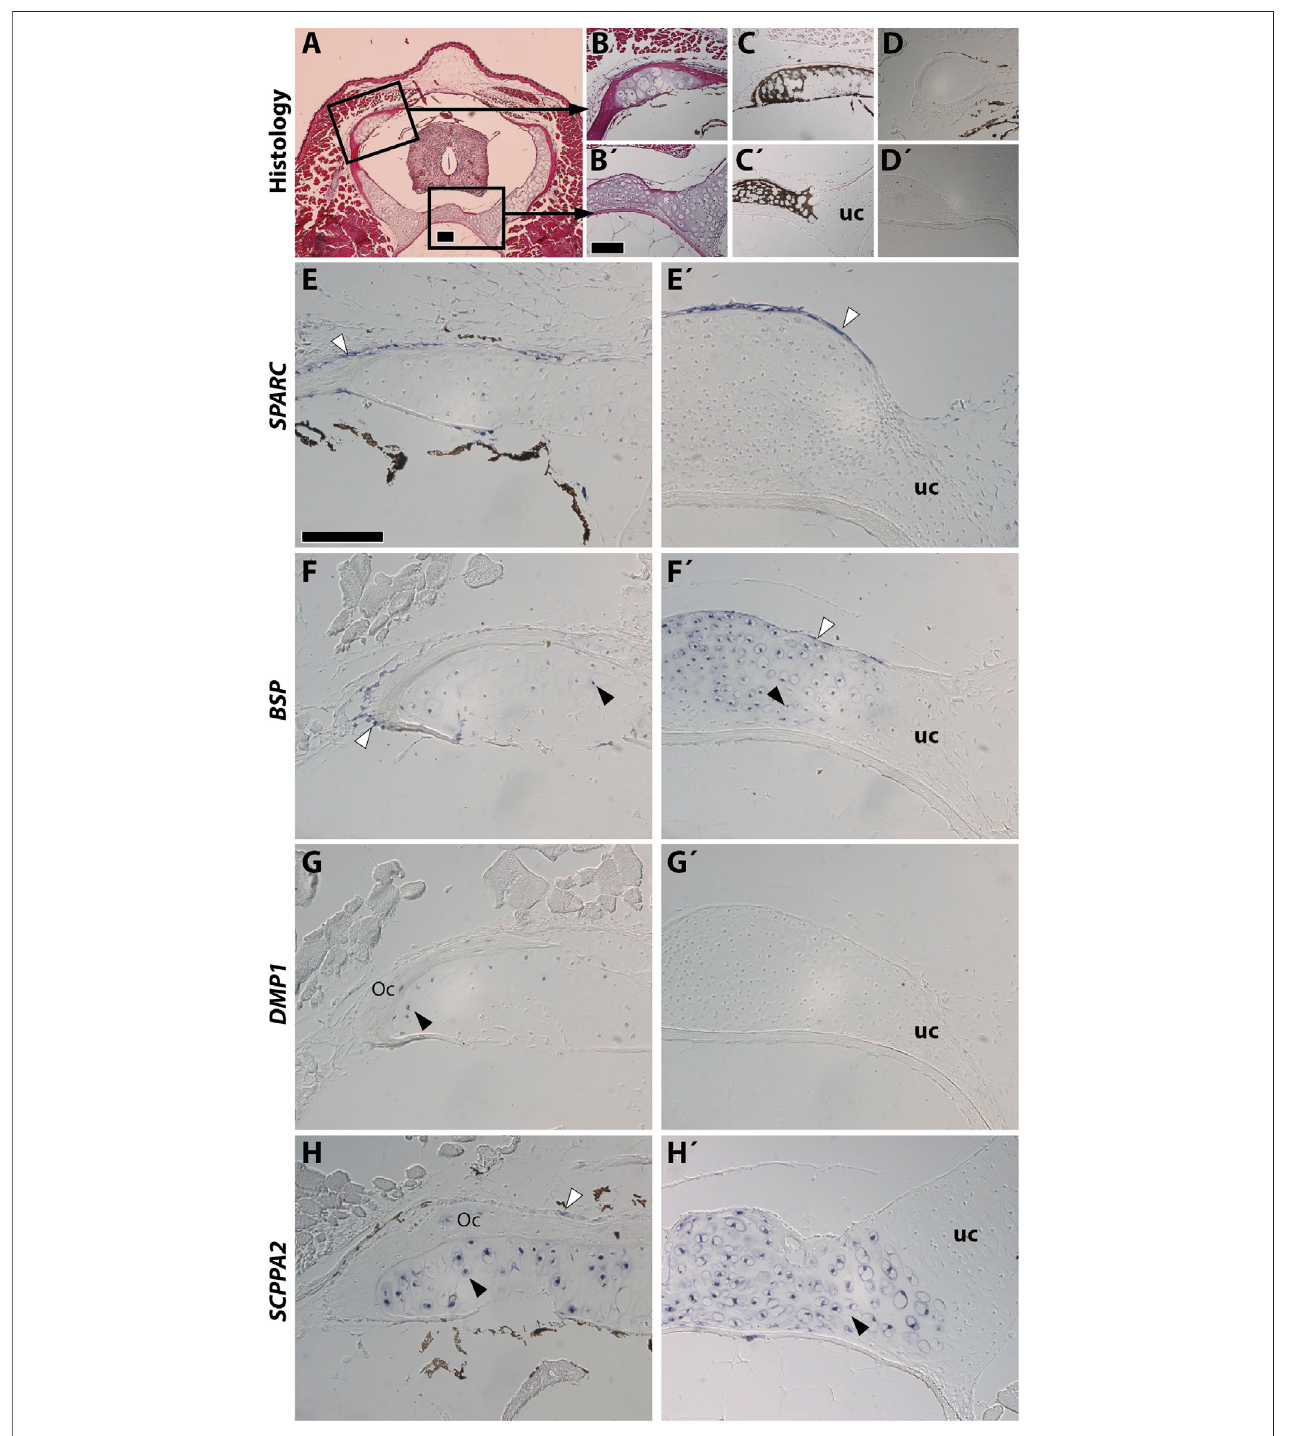
FIGURE4| SPARC and SCPP geneexpressionin Xenopustropicalis stageNF58vertebrae.Transversalsectionsof Xenopustropicalis stageNF58vertebraewere subjected to Hematoxylin-Eosin staining (A,B,B 9 ) , von Kossa staining (C,C 9 ) , or in situ hybridization using a negative control [ SPARC sense probe, (D,D 9 ) ] or an antisense probe for SPARC (E,E 9 ) , BSP (F,F 9 ) , DMP1 (G, G 9 ) , and SCPPA2 (H,H 9 ) . Pictures are orientated with dorsal to the top and show the whole vertebrae (A) , the neural arch (B – H) or the vertebral body (B 9 – H 9 ) . White and black arrowheads show in situ hybridization signal in osteoblasts and chondrocytes, respectively. Abbreviations: uc, unmineralized cartilage, Oc osteocytes showing in situ hybridization signal. Scale bars: (A) , 100 μ m; (B) , 100 µm in (B – D 9 ) ; (E) , 50 µm in (E – H 9 ) .